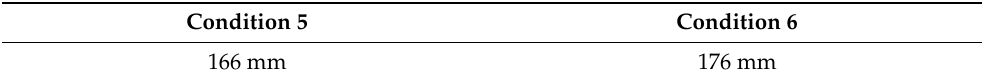
Figure 8. Transverse displacement curves of switch rail separated from stock rail under different stroke conditions at the second traction point. ( a ) Working condition 5, ( b ) Working condition 6. Table 4. Free stroke for the first traction point under different stroke conditions at the second traction point.